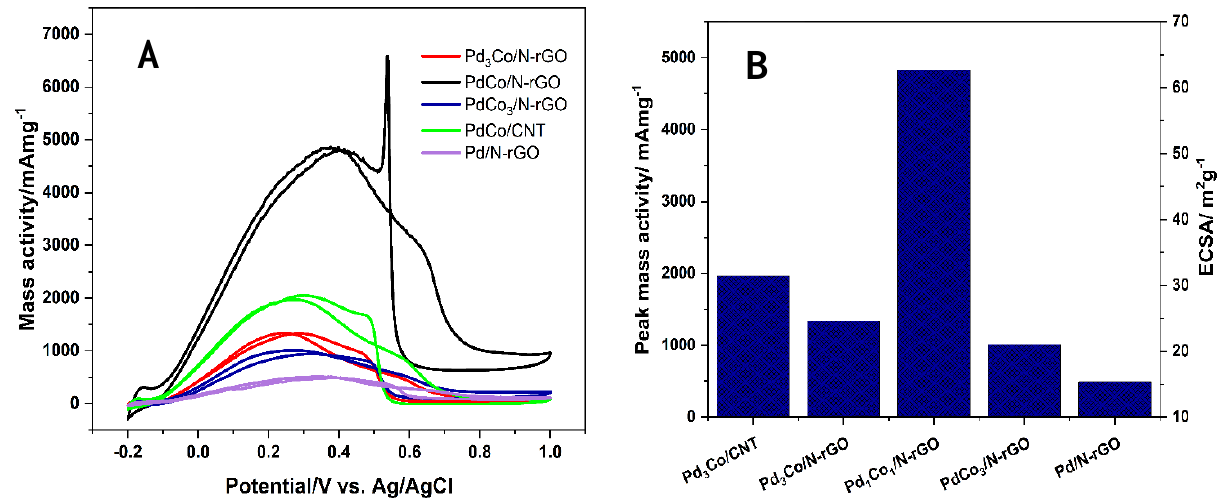
11 of 18 Figure 6. C yclic voltammetry curves for Pd 1 Co 1 /N-rGO in ( A ) 0.5 M H 2 SO 4 solution and ( B ) 0.5 M H 2 SO 4 + 0.5 M HCOOH in solution at scan rate 20 mv s – 1 .